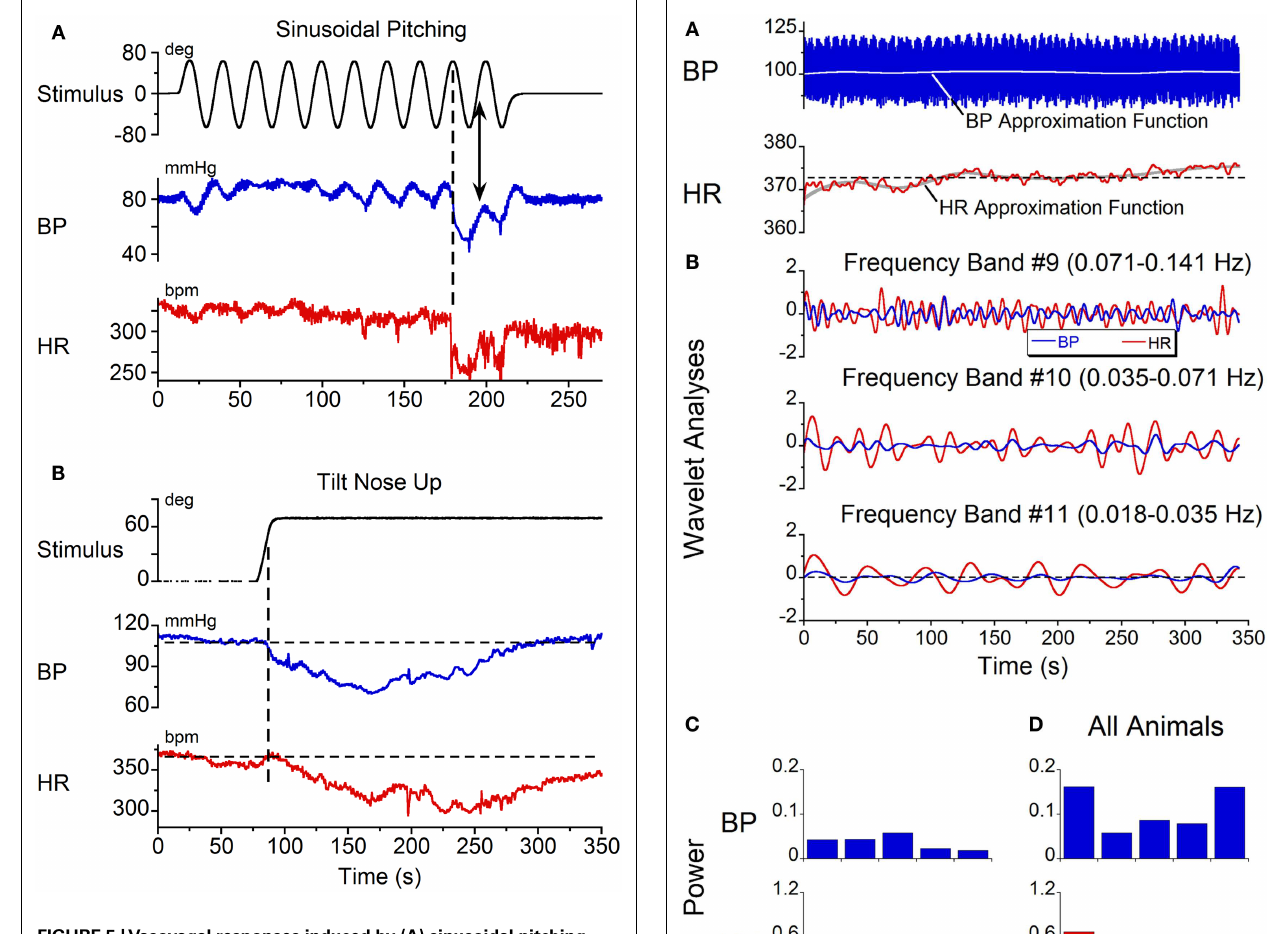
responses with the animals at rest was done to establish a